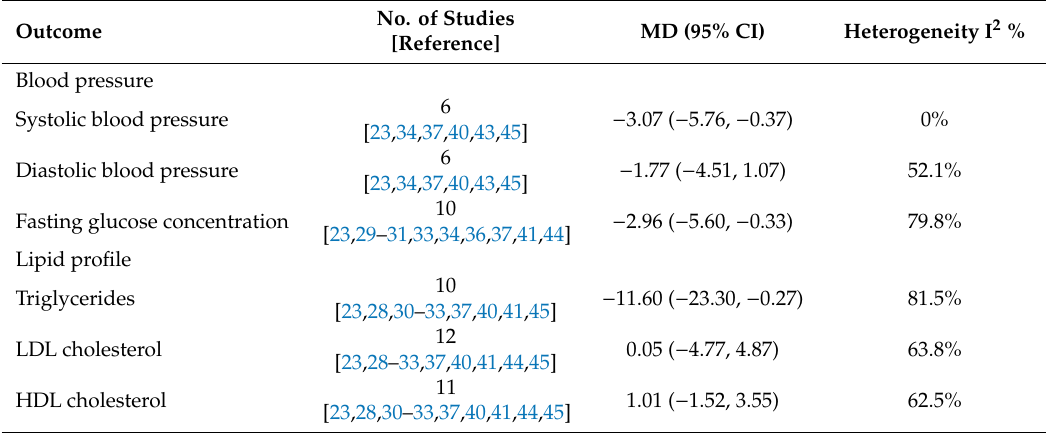
Table 2. Meta-analyses of the e ff ect of TRE on cardiometabolic parameters compared to